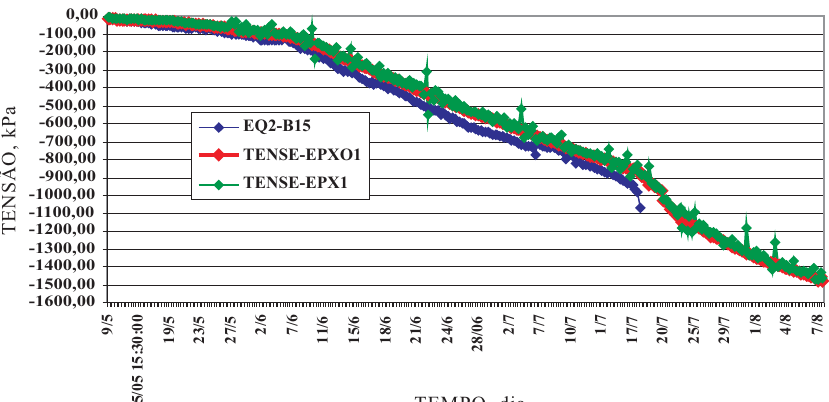
Figura 15. Resultados dos tensiômetros de tensão elevados, correlacionados com os do tensiômetro de equivalência ensaiado no lisímetro (tanque B). (Diene, 2004)